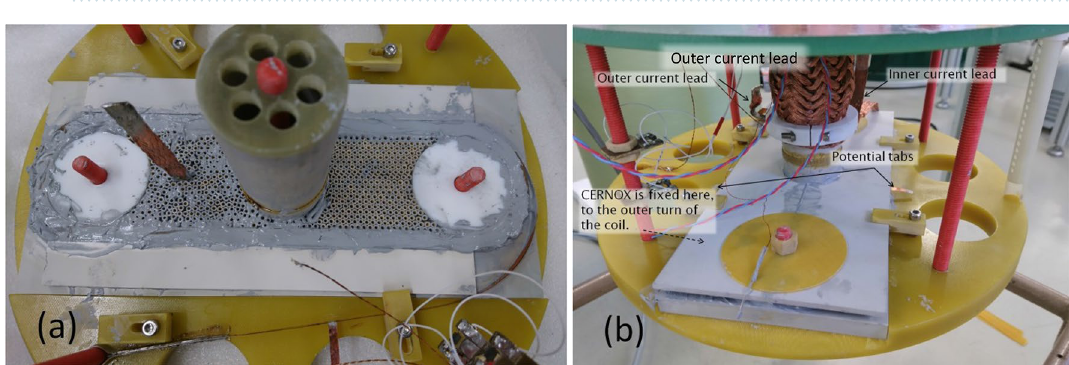
Figure 1. ( a ) Sketch of the coil assembly for AC loss measurements in vacuum in the measuring set-up prior inserting to the cyostat. ( b ) Approximate level of 6 L of solid nitrogen sub-cooled to 23 K.